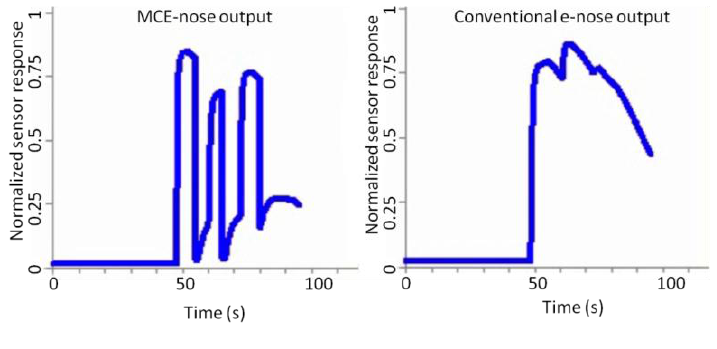
Figure 14. Output readings comparison between a conventional e-nose (right) and the MCE-nose (left) for the multiple gas source experiment. It can be appreciated how the MCE-nose can clearly distinguish the three gas sources, while a conventional e-nose can hardly detect the second source, while the third one became completely